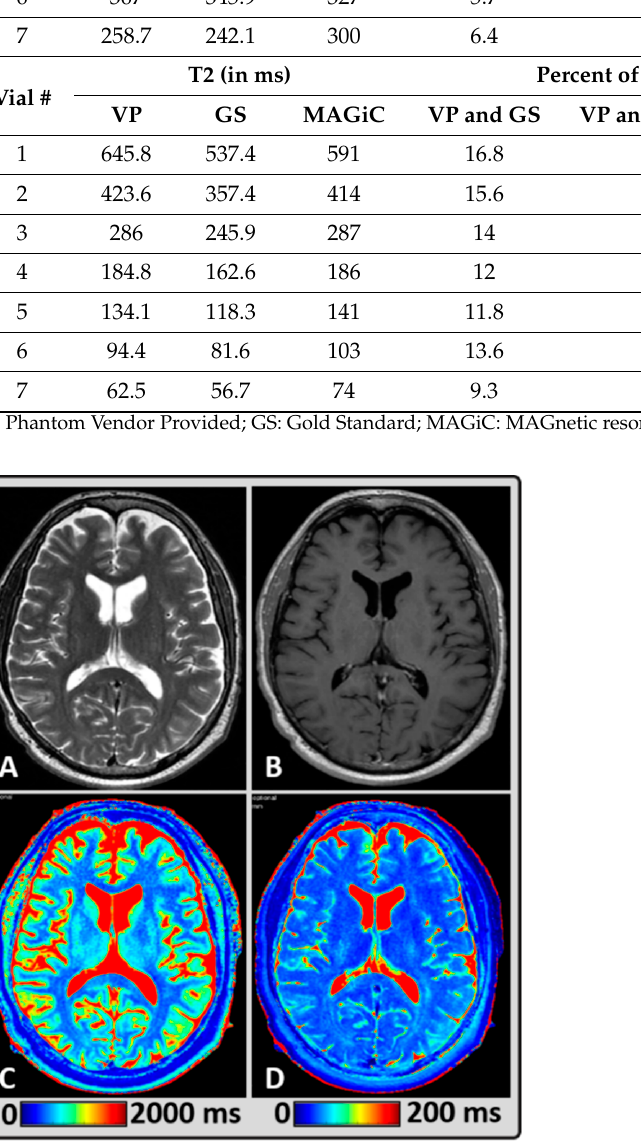
Figure 1. Representative MRI data from a 58-year-old male BM patient treated with focal radiation therapy (RT), showing normal-appearing brain tissue. ( A , B ) standard T2w and post-contrast T1w images depicting the anatomical structures, ( C , D ) T1 and T2 maps were estimated using MAGnetic resonance image Compilation (MAGiC) for a single slice exhibiting gray matter (GM), white matter (WM), and cerebrospinal fluid (CSF).